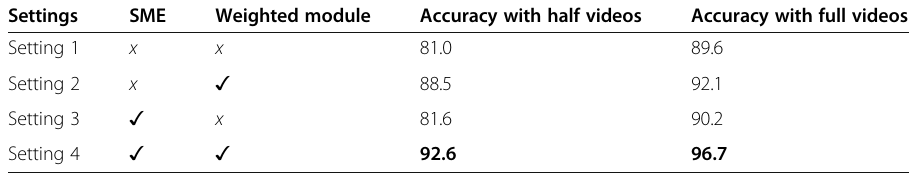
Table 4 Ablative study on UT-Interaction dataset (%) Settings SME Weighted module Accuracy with half videos Setting 1 Setting 3